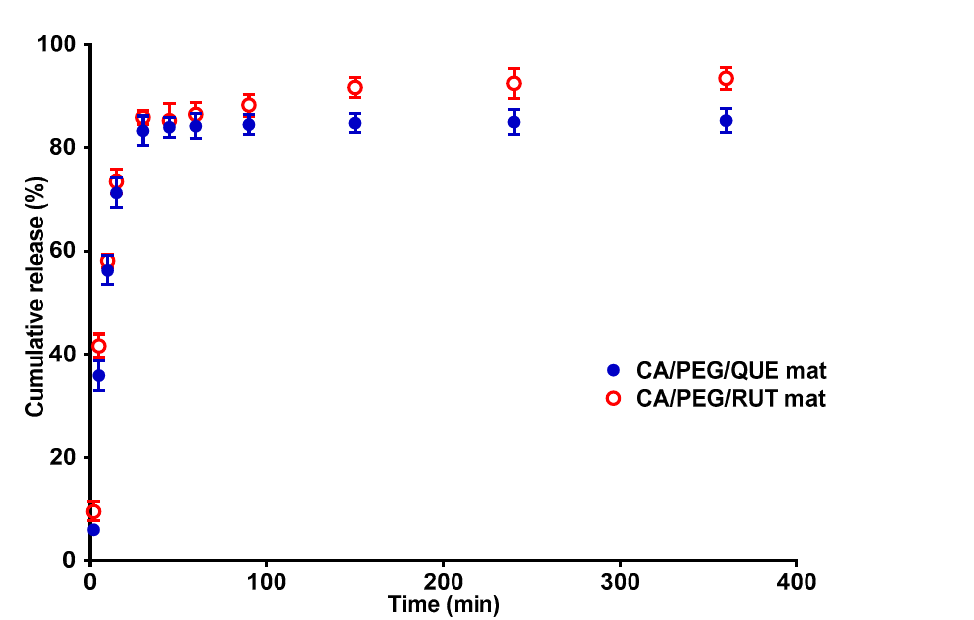
Figure 6. Release profiles of QUE and RUT from CA/PEG/QUE and CA/PEG/RUT fibrous mats. The data are displayed as average values from three different measurements along with their standard deviations, volume ratio of acetate buffer to Tween 80 (99.2:0.8 v / v ), ionic strength of 0.1, pH 5.5, 37 ◦ C. The flavonoid release from the complex fibrous materials is presented in